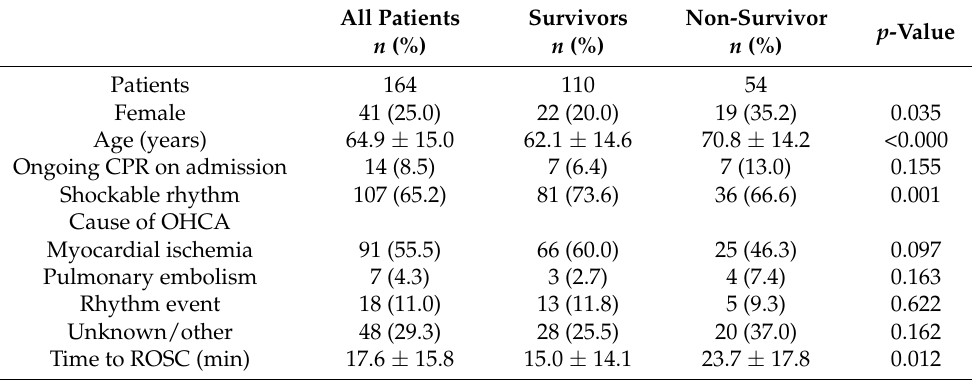
Table 1. Baseline Clinical and Demographic